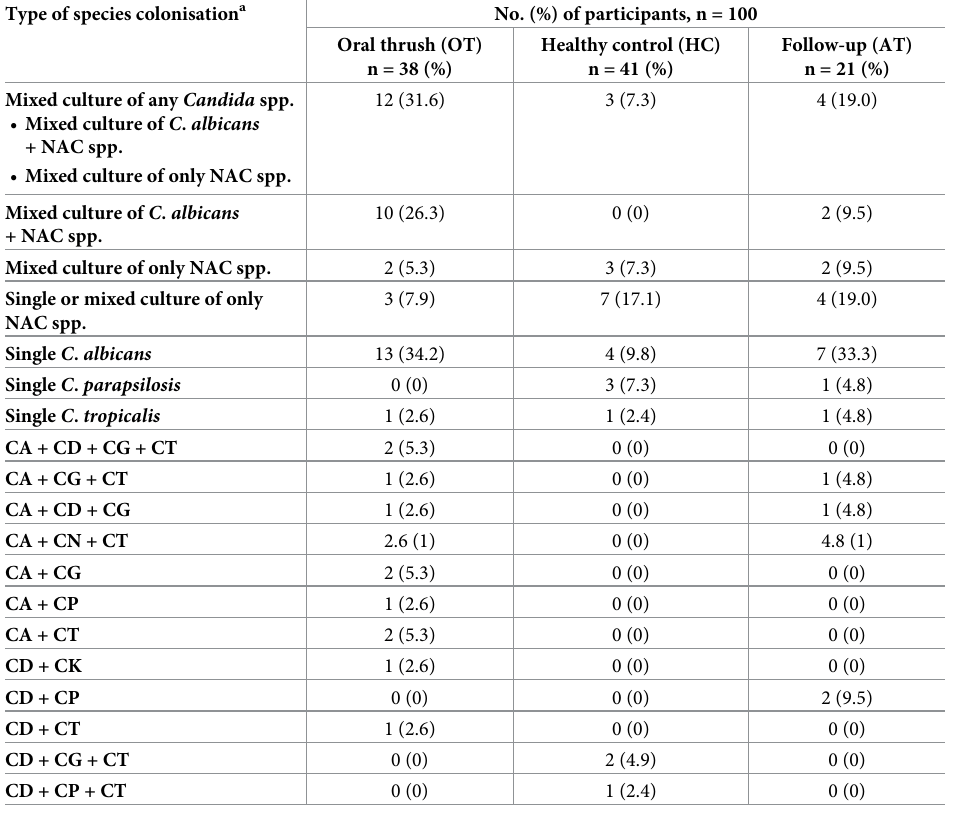
a Abbreviations: +: and; CA: C . albicans ; CD: C . dubliniensis ; CG: C . glabrata ; CK: C . krusei ; CN: C . nivariensis ; CP: C . parapsilosis ; CT: C . tropicalis ; NAC: Non- albicans Candida